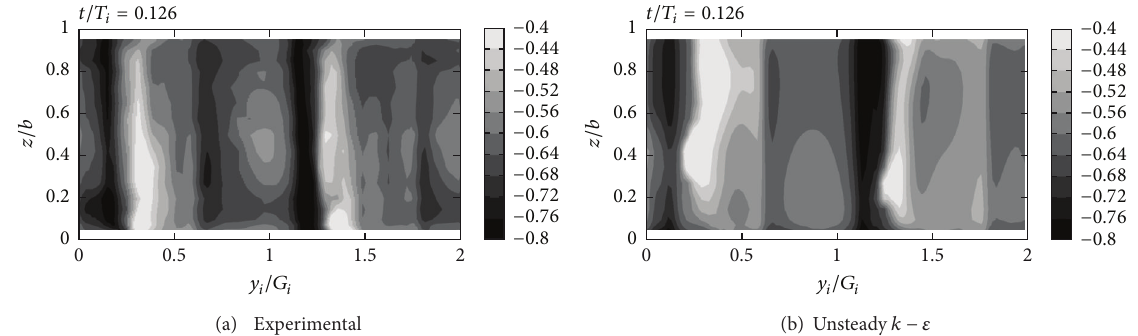
Figure 9: Experimental and calculated tangential velocities in the radial gap for the unsteady simulation using the 𝑘 − 𝜀 turbulence model. t/T i = 0.0